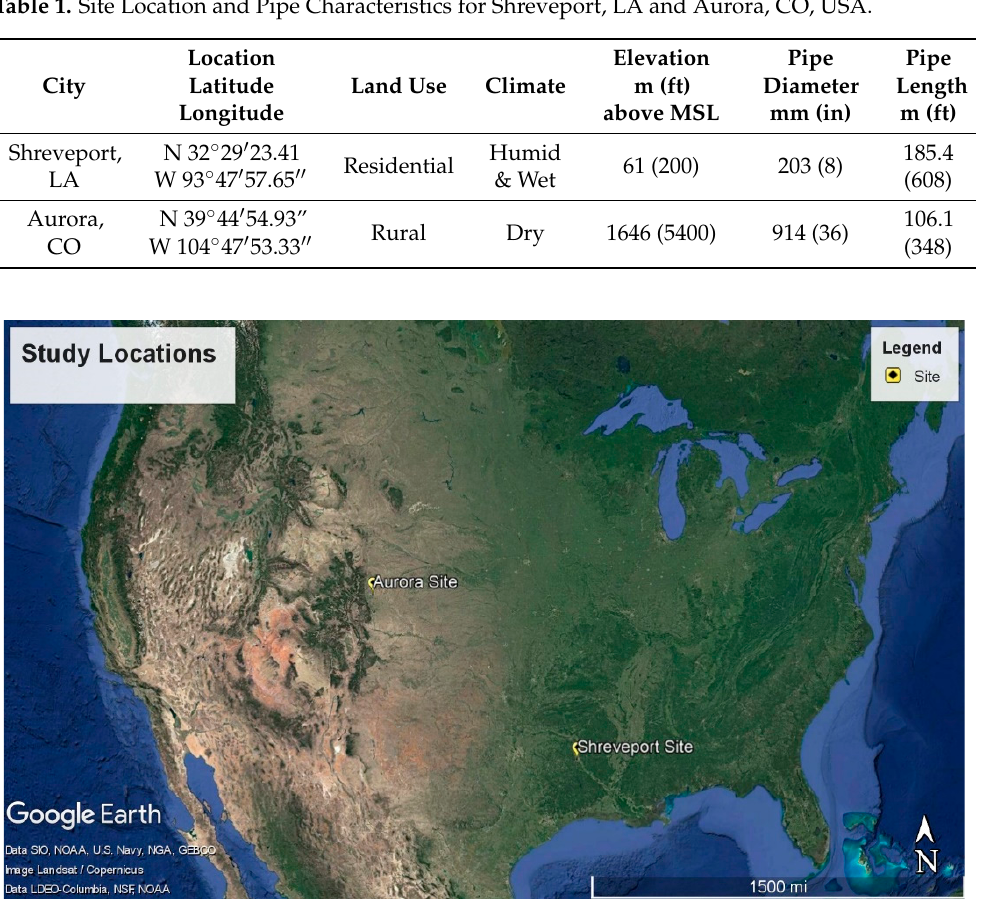
Figure 1. Location of Study on the Continental USA